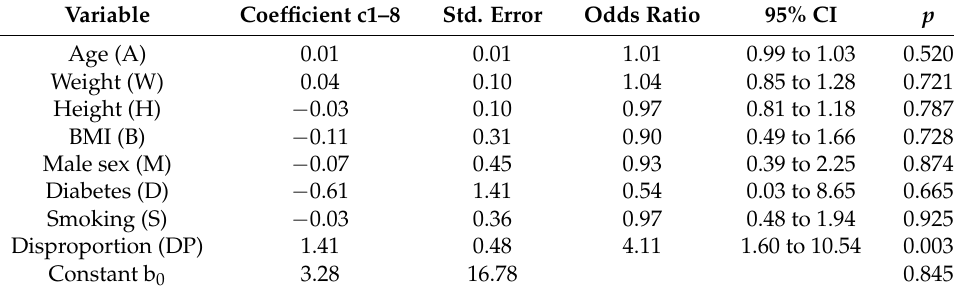
Table 4. Logistic regression of disc herniation with disproportion (DP) and potential confounding